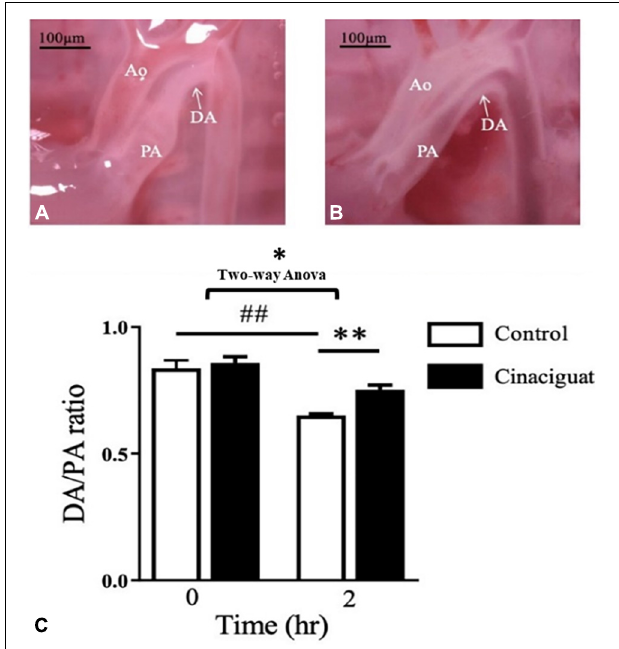
FIGURE 1 | Cinaciguat prevented postnatal ductus arteriosus (DA) closure in neonatal rats. (A) Under dissecting microscope, we found that the DA of control rats closed at 2 h after birth with luminal obliteration. (B) In cinaciguat-injected rats, cinaciguat (10 mg/kg, i.p. at 0 h after birth) prevented DA closure with luminal patency at 2 h after birth. (C) The bar graph showed serial changes in the DA/pulmonary artery (PA) ratio in both groups. In the control group, the ratio declined significantly within 2 h after birth. Comparing control at 2 h after birth, cinaciguat group had higher DA/PA ratio. Values represent the mean ± SEM; N = 6. Ao, aorta; PA, main pulmonary artery; DA, ductus arteriosus. * P < 0.05 by the two-way ANOVA analysis; ## and ** P < 0.01 by the post hoc test; magnification 10 × .